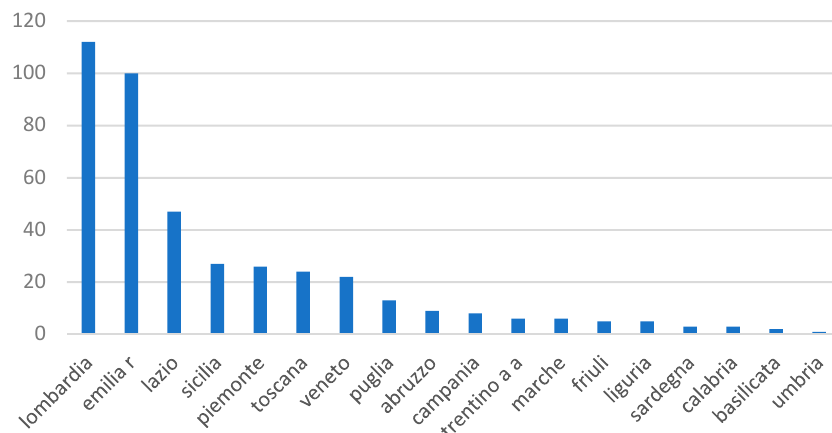
Figure 4. The location of Social Streets in the Italian provinces. Source: authors’ elaboration from the reference [30]